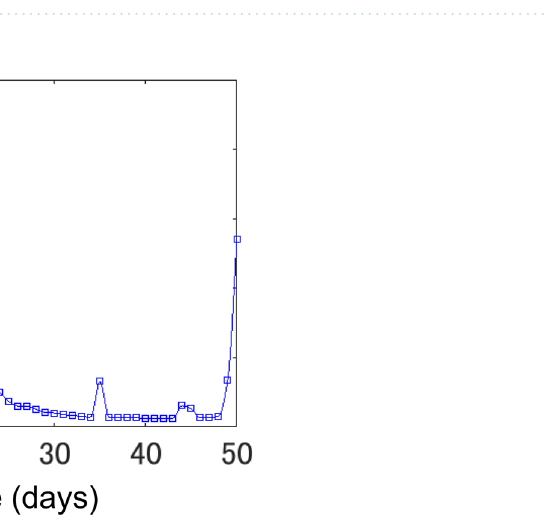
Figure 4. Ang2/Ang1 in the new vessel sprouting area. The x-axis represents time, while the y-axis represents the average Ang2/Ang1 values at new blood vessel branching